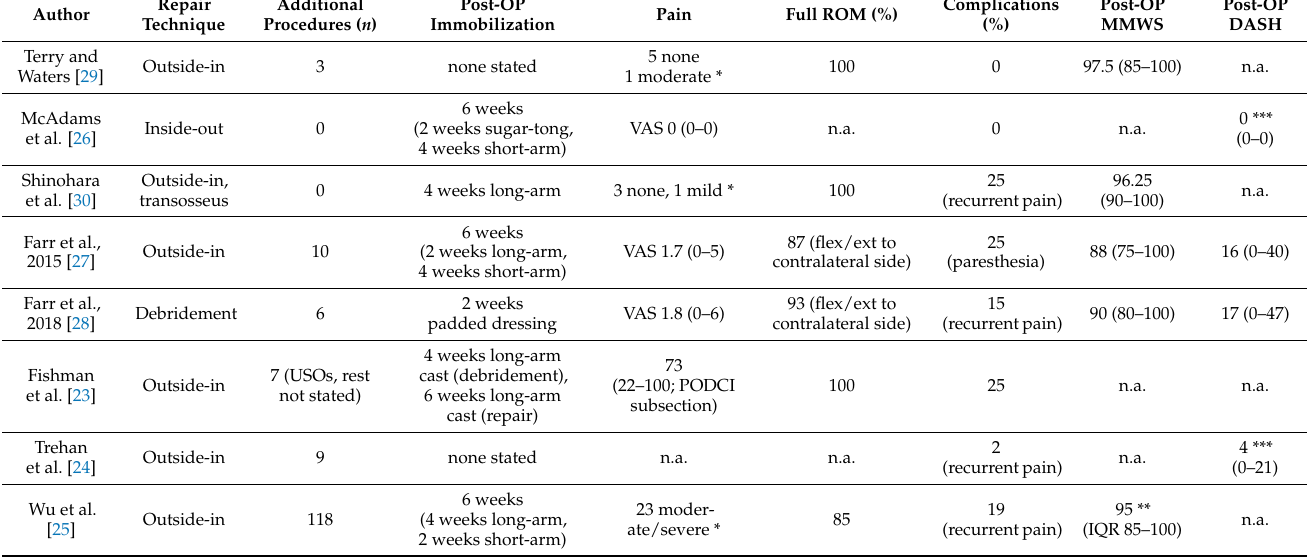
Table 3. Clinical